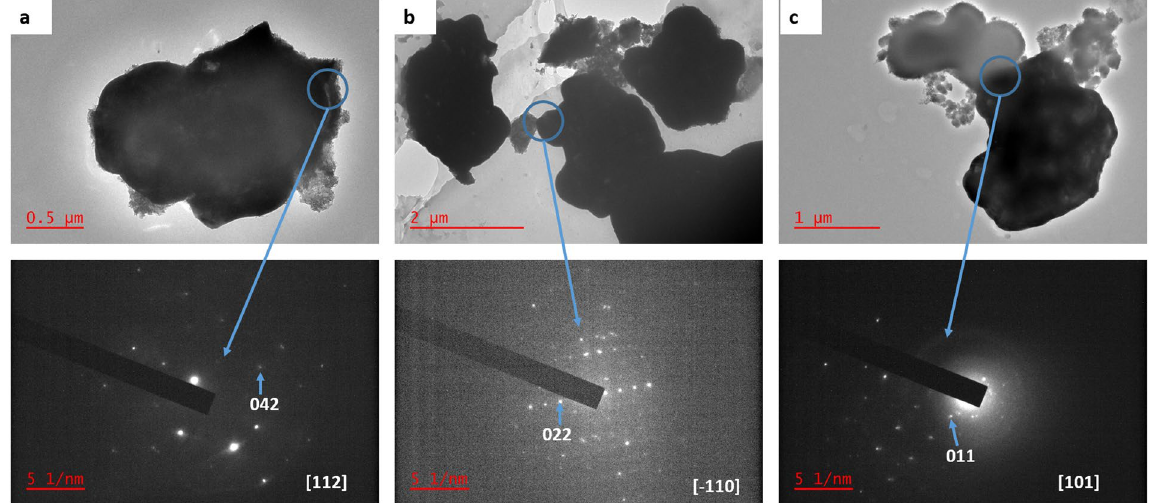
Figure 3. TEM images and respective SAED patterns of ( a ) 1–1 Bi:Ti, ( b ) 2–3 Bi:Ti and ( c ) 3-2 Bi:Ti composites of MIL-125(Ti)/BiVO